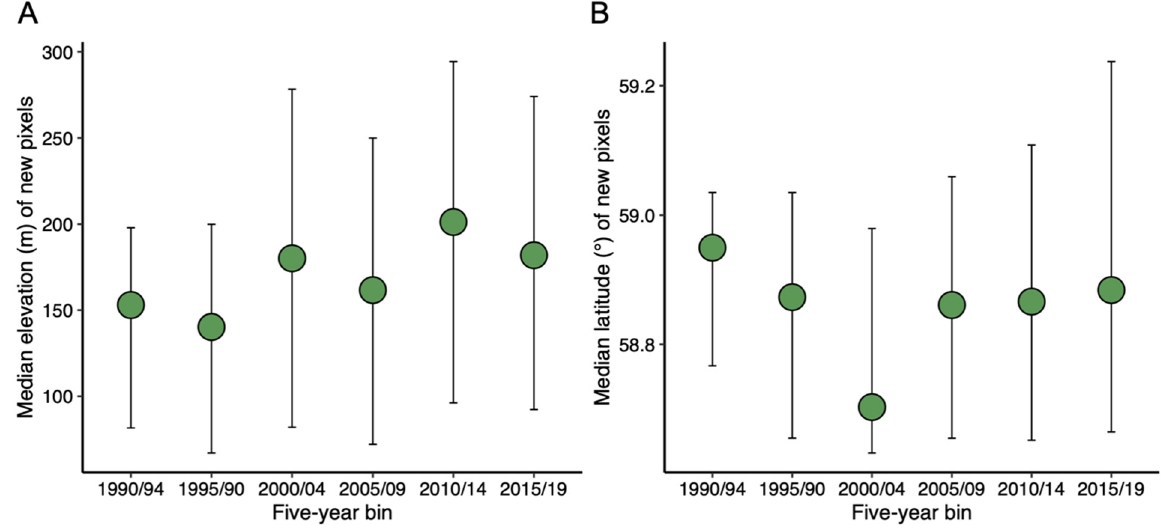
Figure 5. Median (green dot) and 25th and 75th percentiles (bars) of the elevation ( A ) and latitude ( B ) of new shrub pixels in binned land cover rasters. New shrub pixels were determined by masking (removing) the shrub pixels present in the previous five-year raster (thus, 1985/89 not shown).